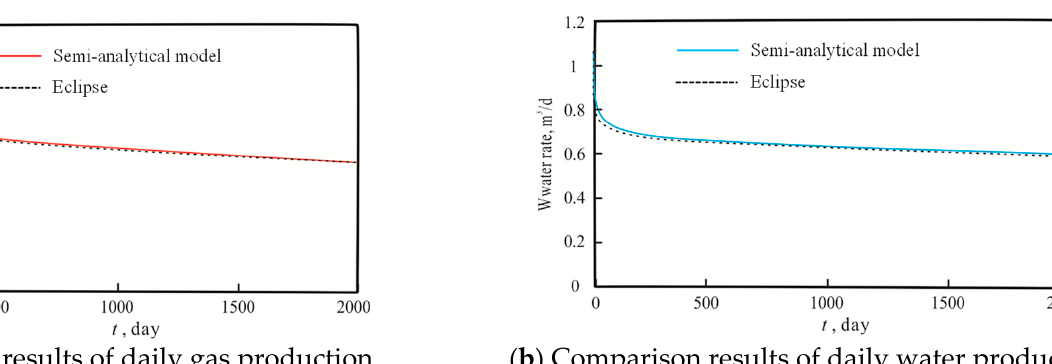
Figure 4. Comparison of production performance from the semi-analytical method and numerical simulation method.